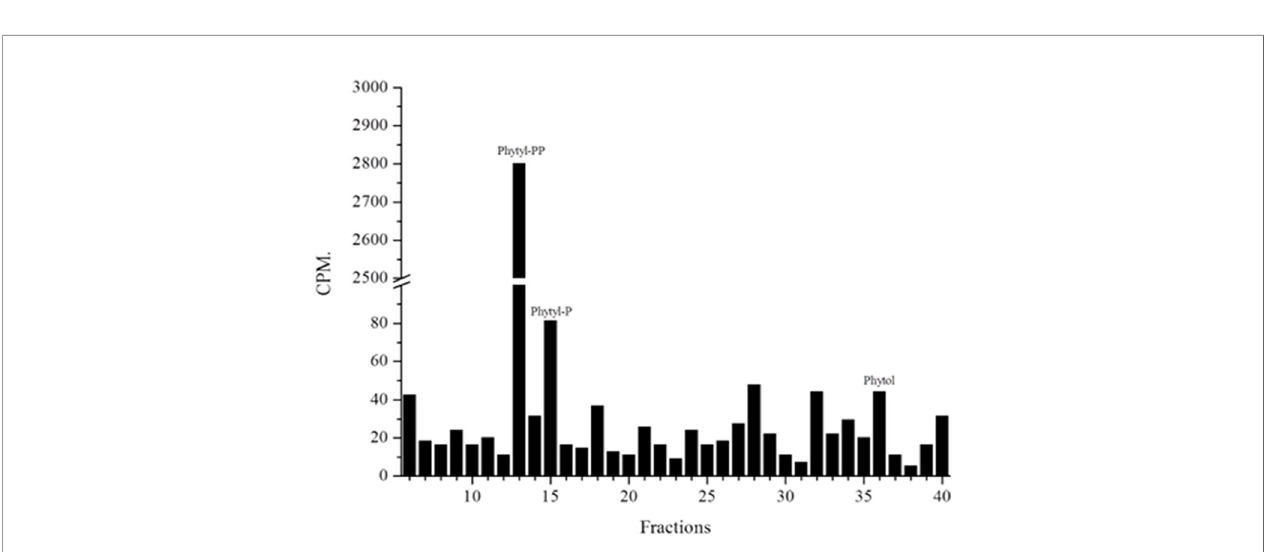
FIGURE 7 | Phytol phosphorylation assay.Parasiticprotein extracts labeled with [1-(n)- 3 H]-phytol were prepared as described andstudied byIschebecket al. (9) and Valentinet al. (35)and analyzed byRP-HPLC(system II).Extracts rich in parasiticmembranes were used.Fractionscontaining phytyl-P, phytyl-PP and phytol are